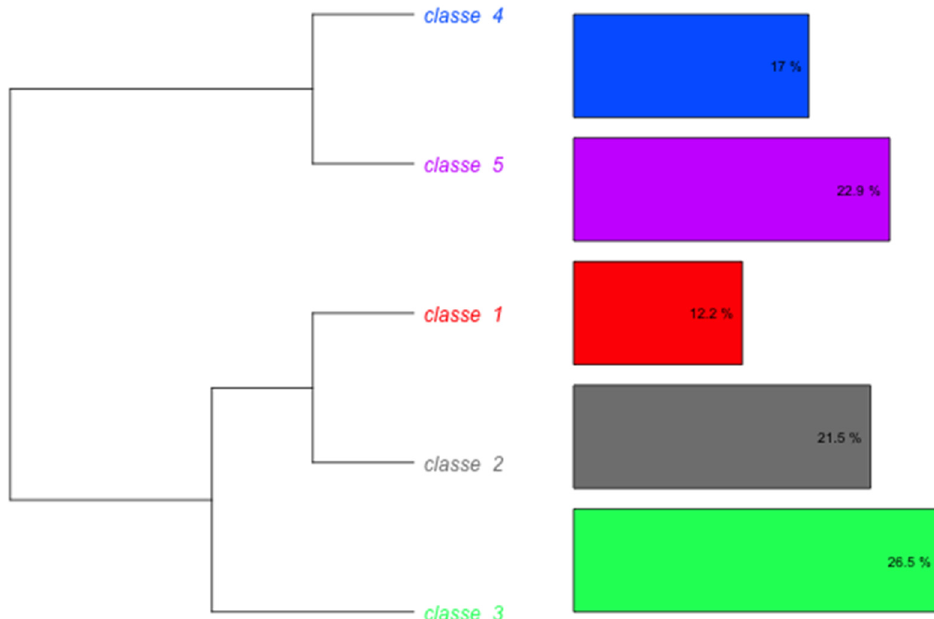
Figure 3. Dendrogram—first interview—parents.